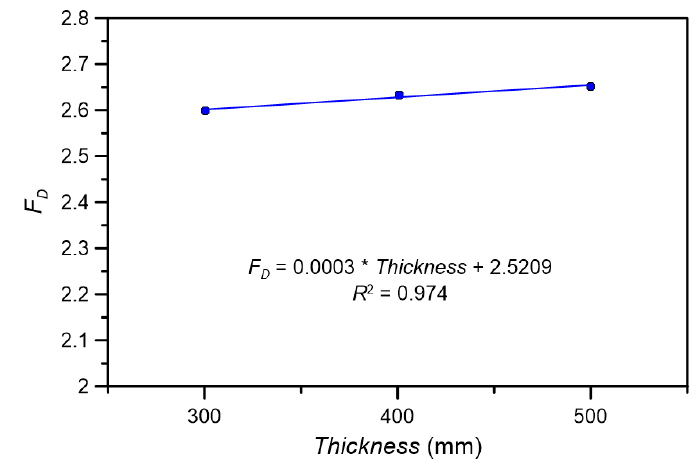
Figure 11. Thickness vs. fractal dimension for experiment OT2.